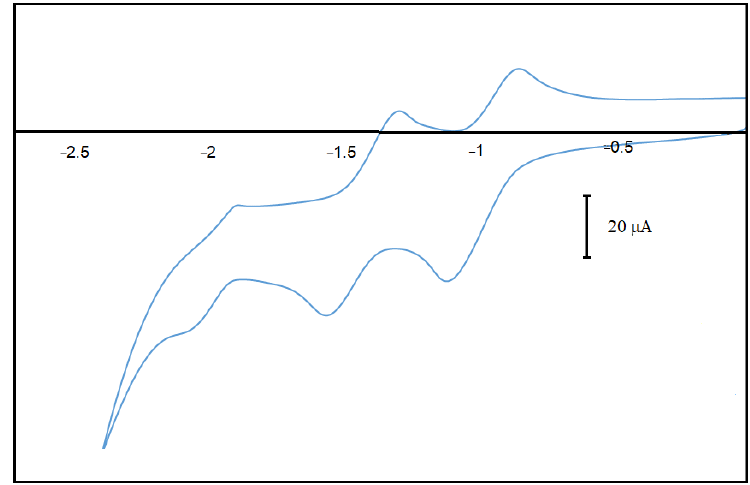
Figure 2. Reversible CVs of dyad 1 upon scanning in reduction to negative potentials.